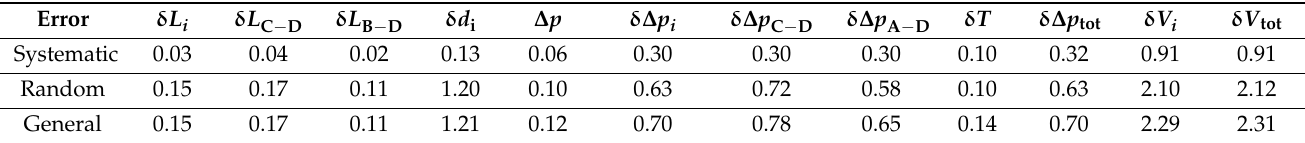
Table A2. Results of the uncertainty analysis (percentage uncertainties with 95% confidence)